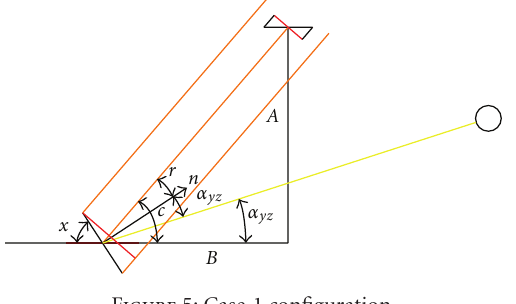
Figure 5: Case 1